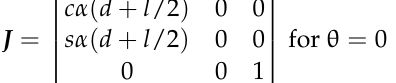
When the bending angle of the manipulator was zero as shown in Figure 4a, the Jacobian could be obtained by taking the limit of the joint angle at θ = 0 using Equation (3). Then the Jacobian was rewritten as Equation (18):